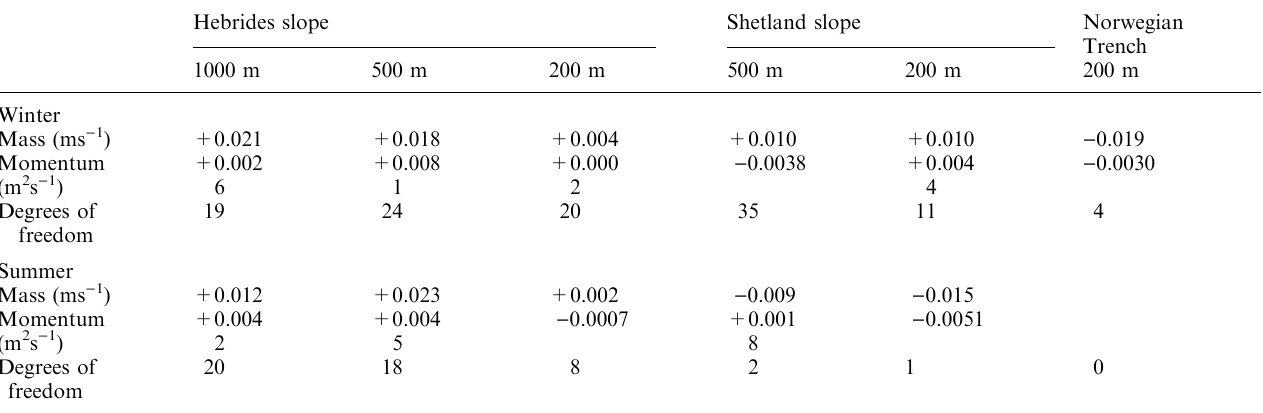
Table 4. Mean mass flux velocities, and momentum flux h uv i calculated for all drifters crossing the specified shelf edge and slope contours. The number of degrees of freedom in each estimate is given Hebrides slope Shetland slope Norwegian